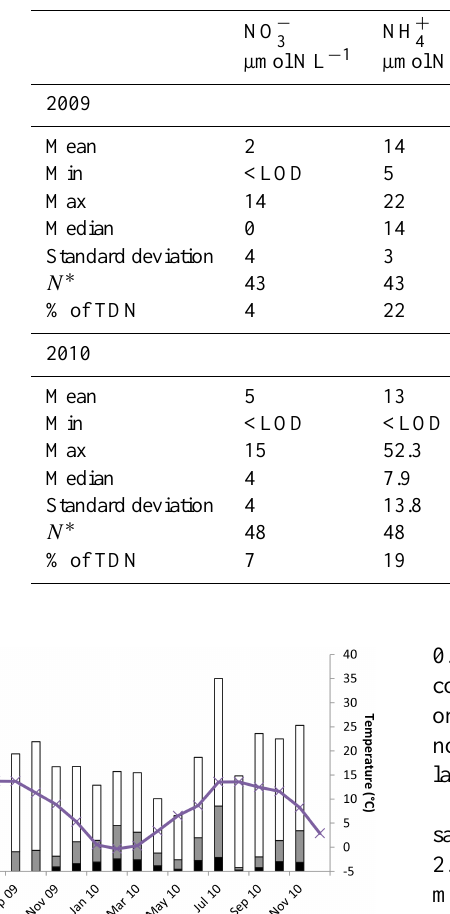
, NO − , DON and TDN for 2009 and 2010 in stream water. Values are based on individual 4 3